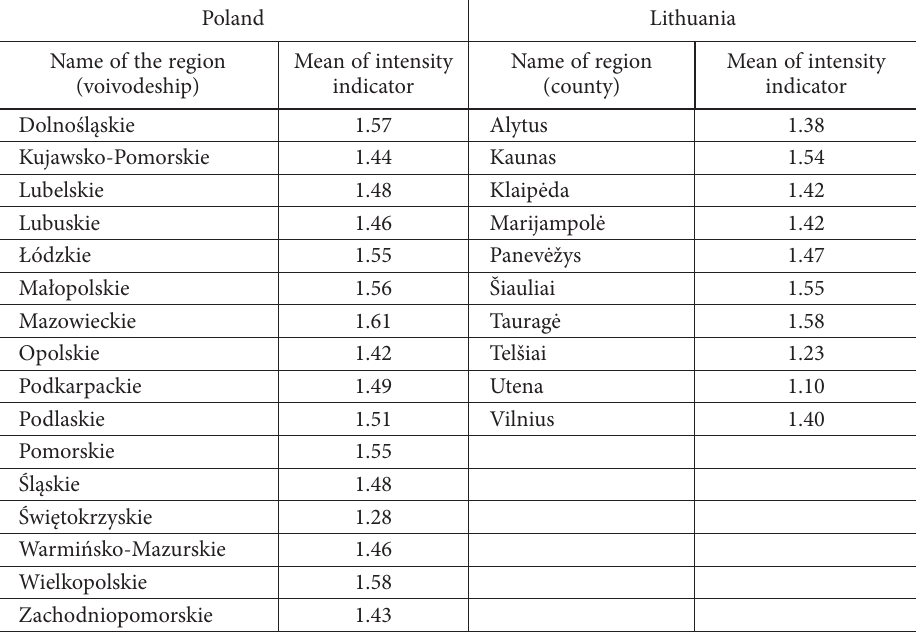
Table 3. Economic development intensity of Polish and Lithuanian regions over the period of 2008–2017 (source: compiled by authors based on Ginevičius et al.,